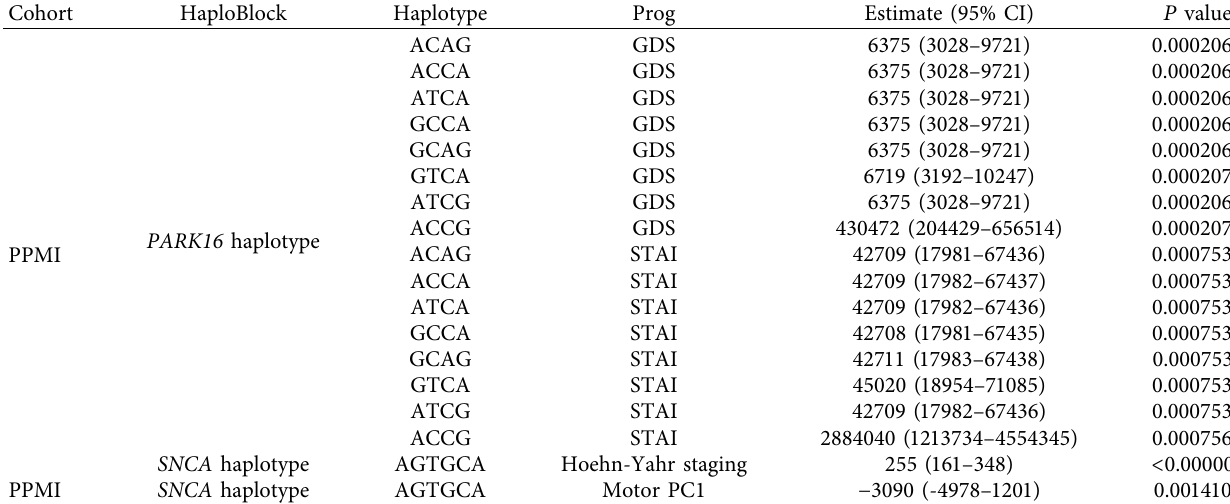
Table 4: Association between haplotypes and progression in the TW and PPMI